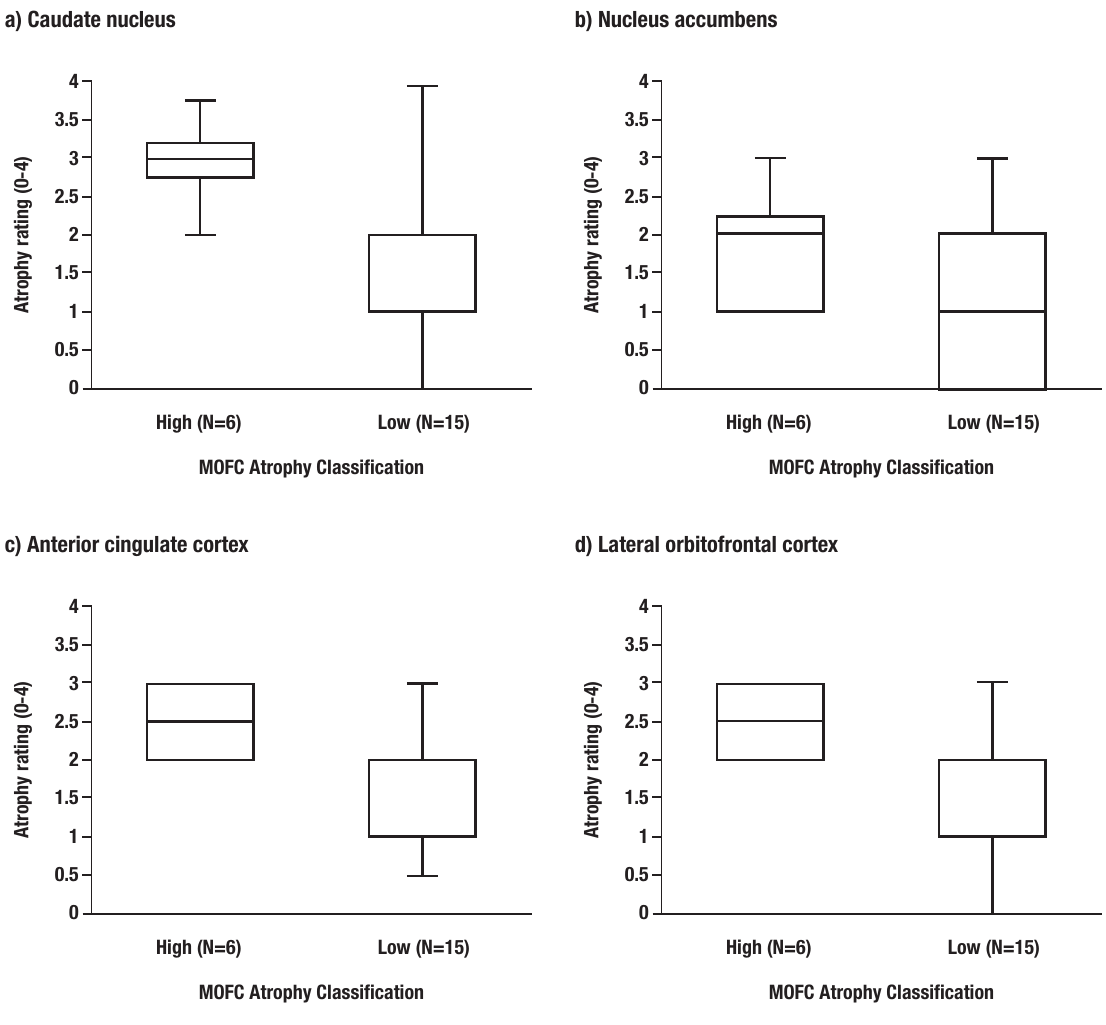
Figure 1. ALS patients with high and low medial orbitofrontal cortex (MOFC) atrophy comparison on striatal atrophy (caudate nucleus and nucleus accumbens) and prefrontal cortex atrophy (anterior cingulate cortex and lateral orbitofrontal